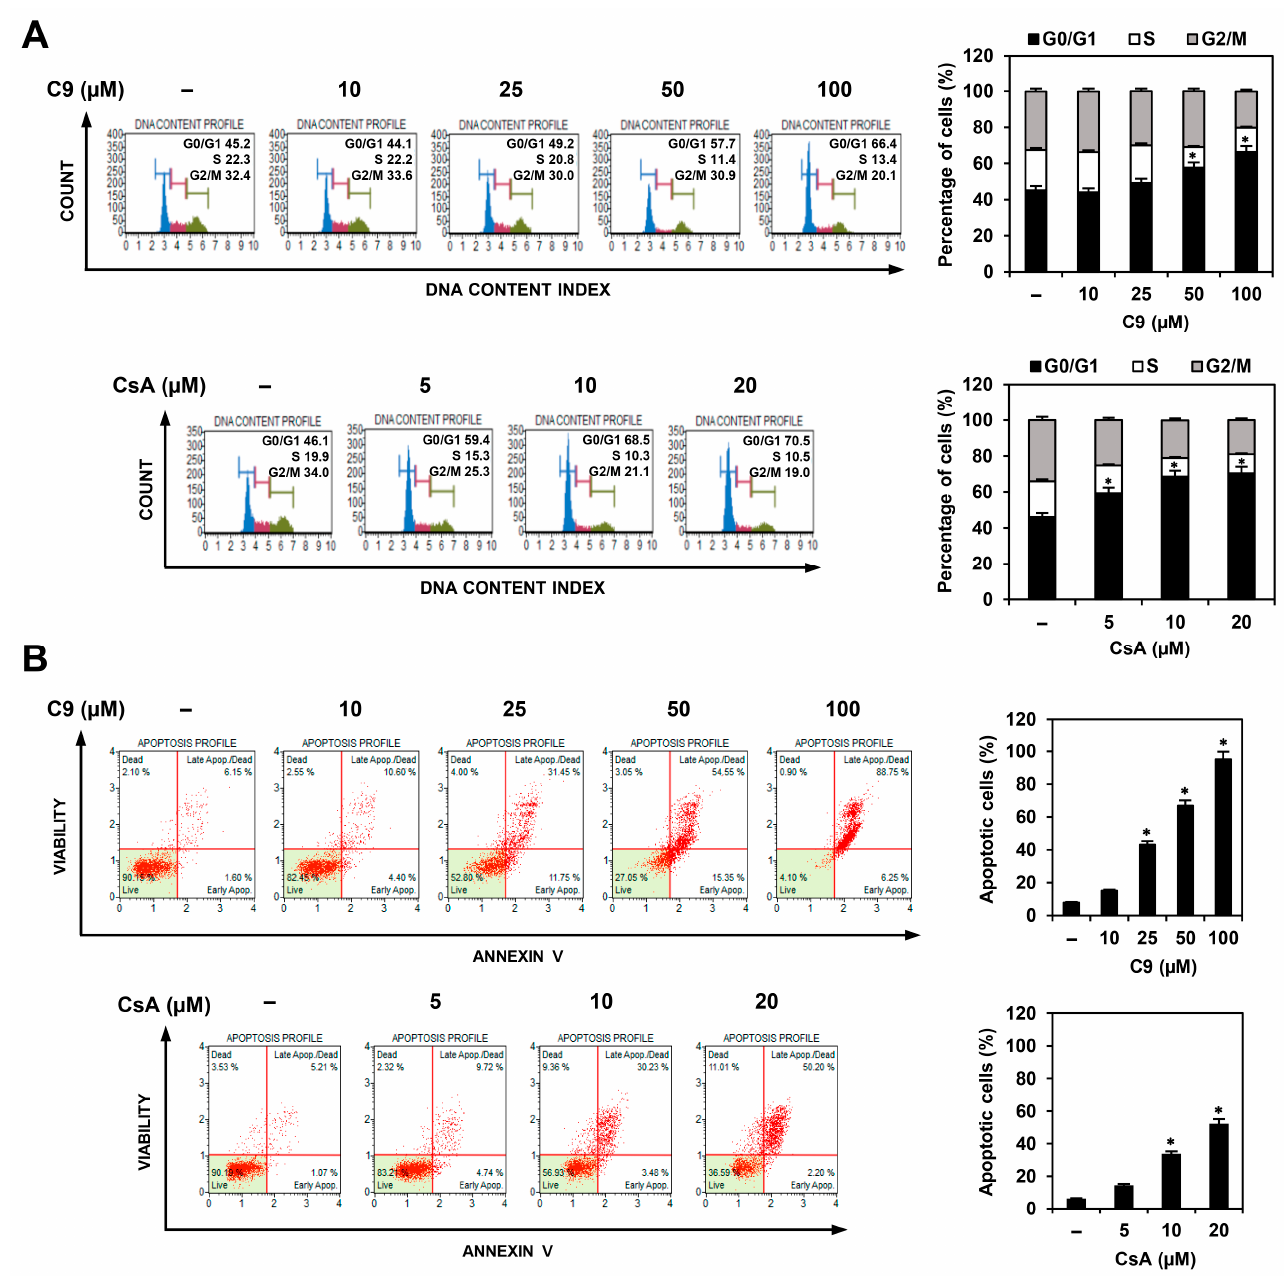
Figure 6. Effects of C9 and CsA on the cell cycle and apoptosis in MKN45 GCSCs. ( A , B ) MKN45-derived GCSCs were treated with the indicated concentrations of C9 and CsA for 72 h. ( A ) Effects of C9 and CsA on the cell cycle. Cell cycle distribution was detected using a Muse Cell Analyzer with a Muse ® Cell Cycle kit. ( B ) Effects of C9 and CsA on apoptotic cell death. Apoptotic cells were detected using a Muse Cell Analyzer with a Muse ® Annexin V & Dead Cell kit. * p < 0.05 vs. the